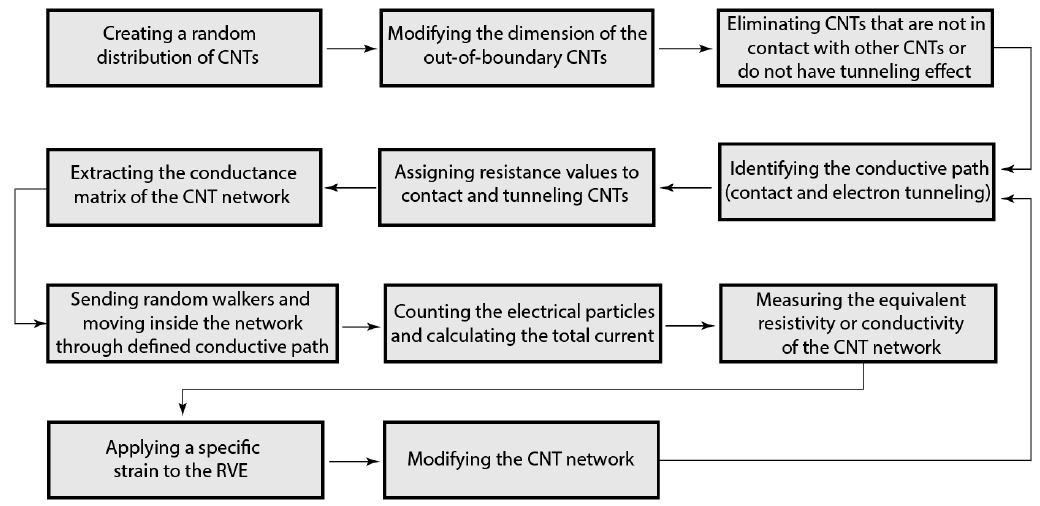
Figure 10. Prosses modeling of a piezoresistive CNT network using random walks method.